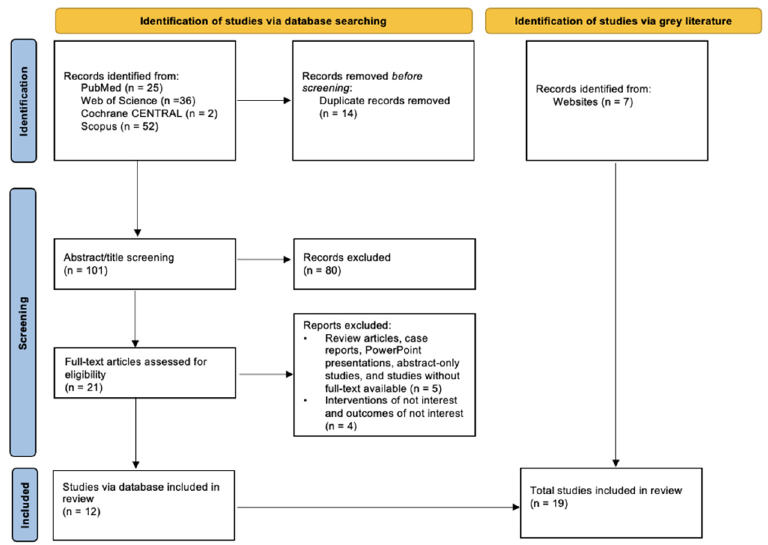
Figure 1. PRISMA Diagram.